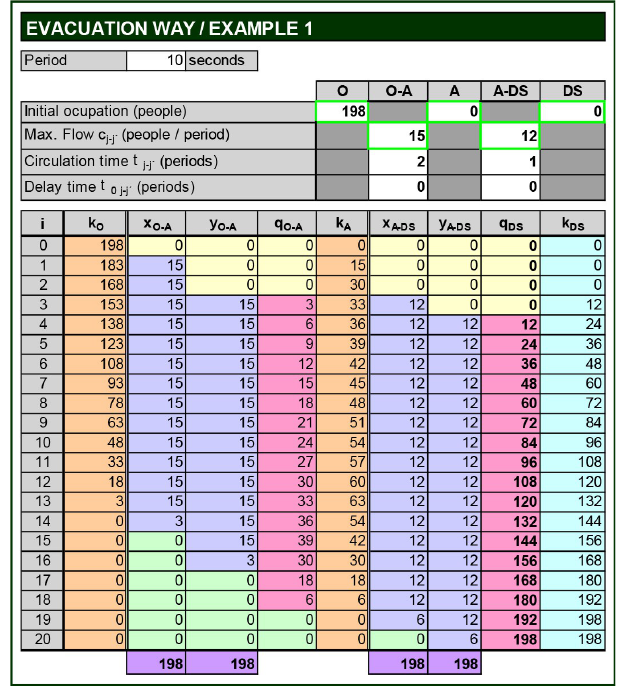
Figure 10. Example: Table of results of the dynamic network of an evacuation route